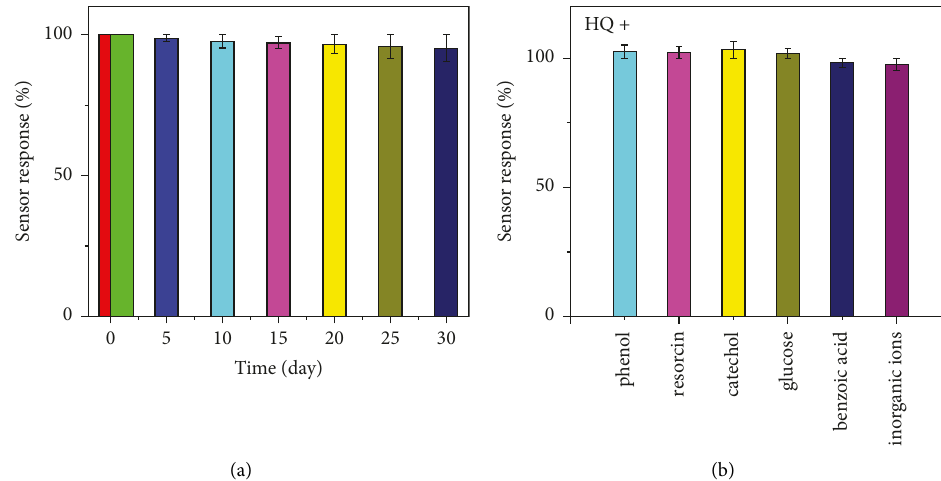
Figure 10: (a) Storage stability of Cu/rGO/GCE stored in a constant temperature drying oven, (b) the selectivity of the proposed method for HQ determination. The concentration of HQ is 5 μ M, concentrations of phenol, resorcin, catechol, glucose, and benzoic acid are 0.5mM, concentration of inorganic ions is 1mM; the error bars illustrate the standard deviations of six independent measurements. Table 2: Determination results for HQ in local tap and reservoir water.